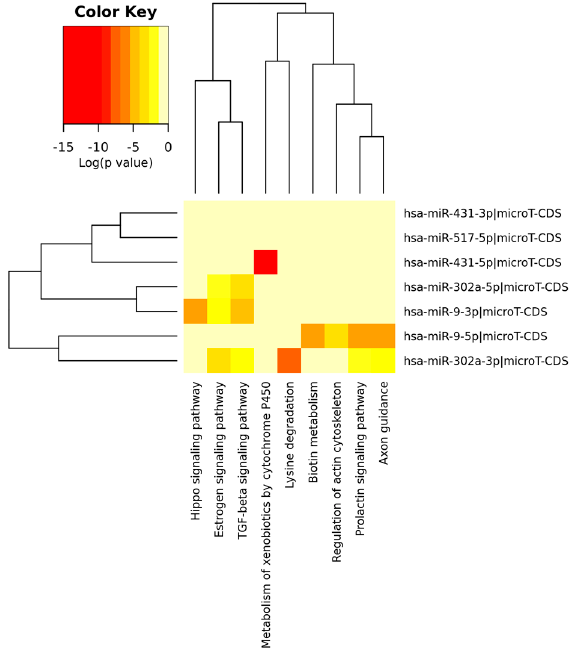
Figure 2. Heatmap of significant predicted upregulated miRNAs (both 5’ and 3’ arm) and relative KEGG activated pathways. The color in the heatmap represents the significance levels ( p -values) between each miRNA and every pathway. A merged p -value is extracted by combining the previously calculated significance levels, using Fisher’s meta-analysis method. Thus, the resulting merged p -values signify if a particular pathway is targeted by at least one miRNA out of the initially selected group.